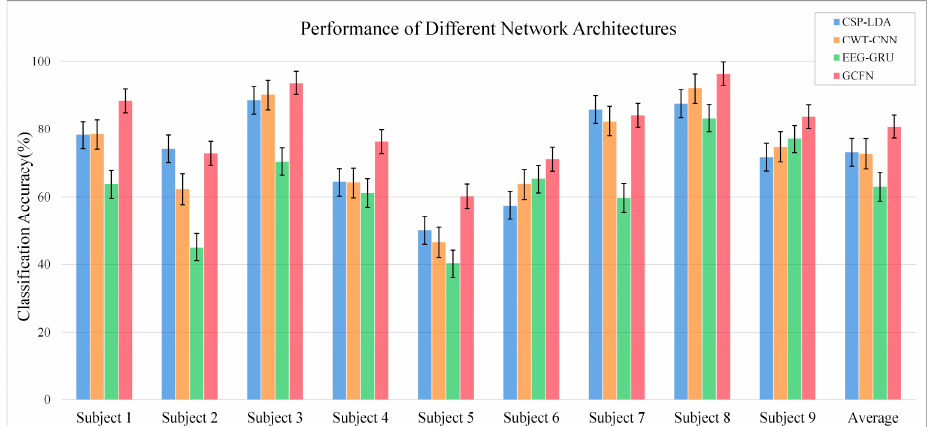
Figure 8. Average classification accuracy of each subject.